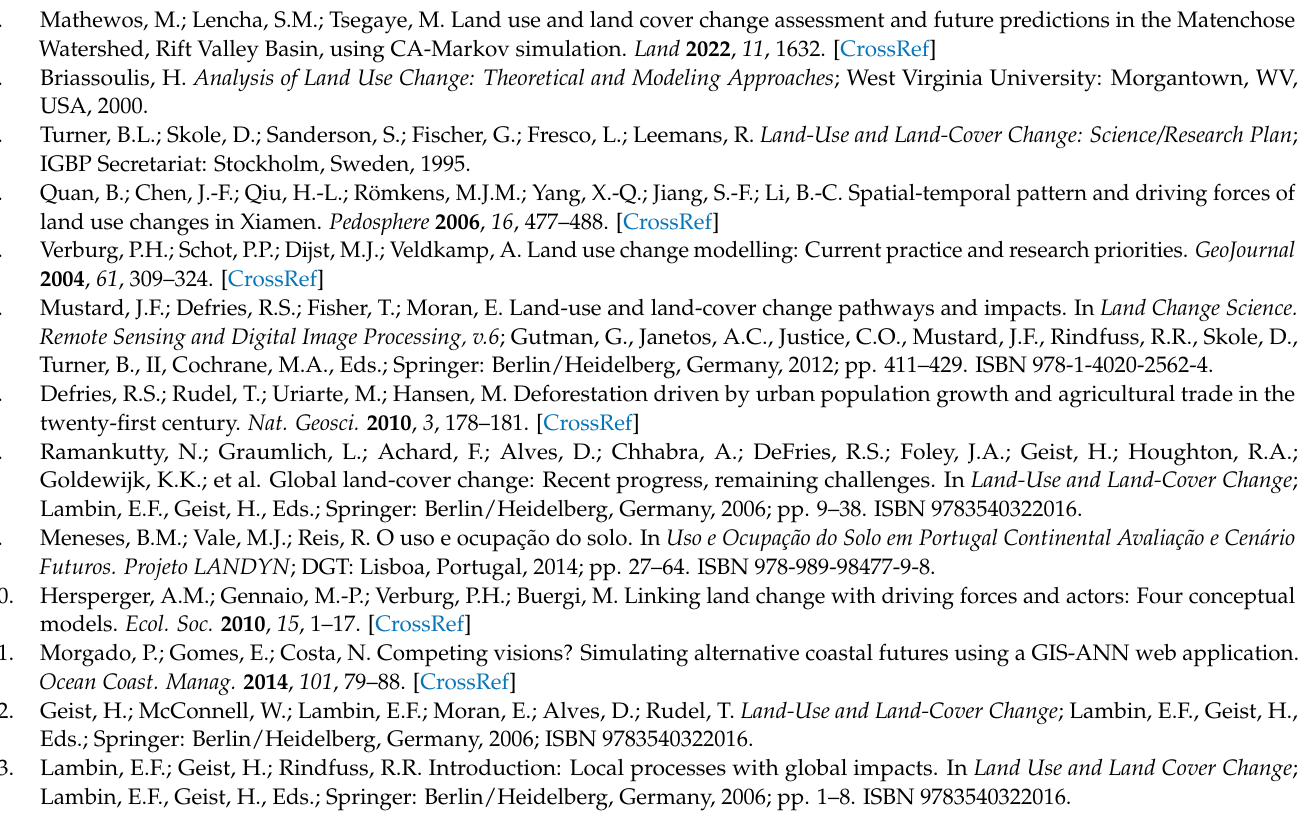
table of the construction of the predictive scenarios is available online, Report S2: scenario